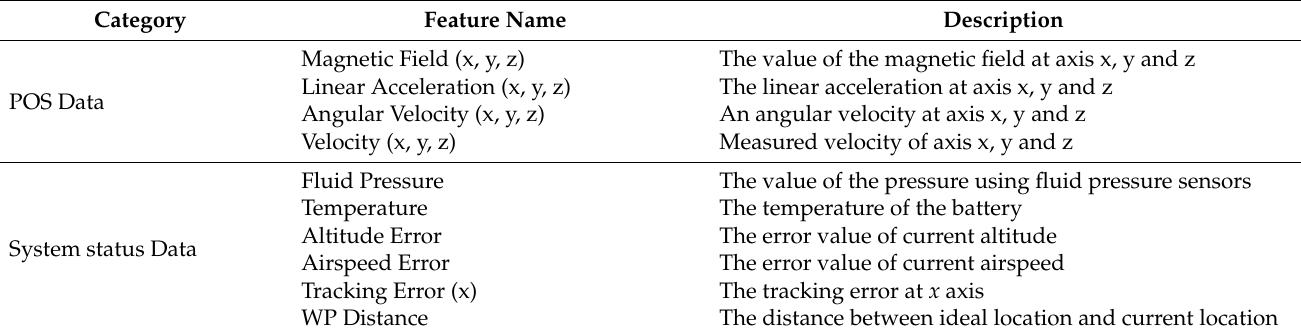
Table 1. Features selected from the